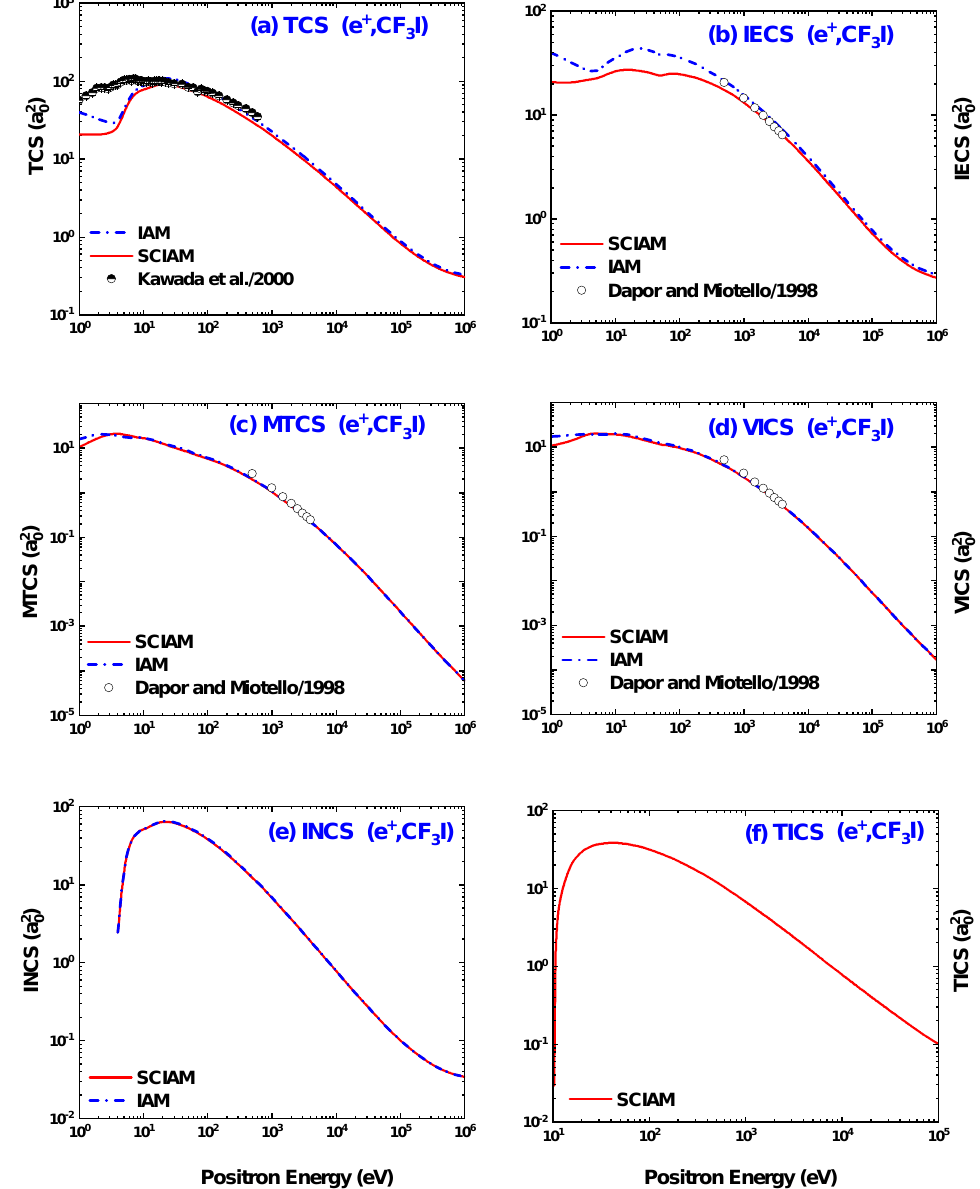
Figure 11. ( a ) TCS, ( b ) IECS, ( c ) MTCS, ( d ) VCS, ( e ) INCS, and ( f ) TICS for the scattering of positrons from CF 3 I. Theoretical works: IAM, SCIAM, Dapor and Miotello [41]. Experimental works: Kawada et al.